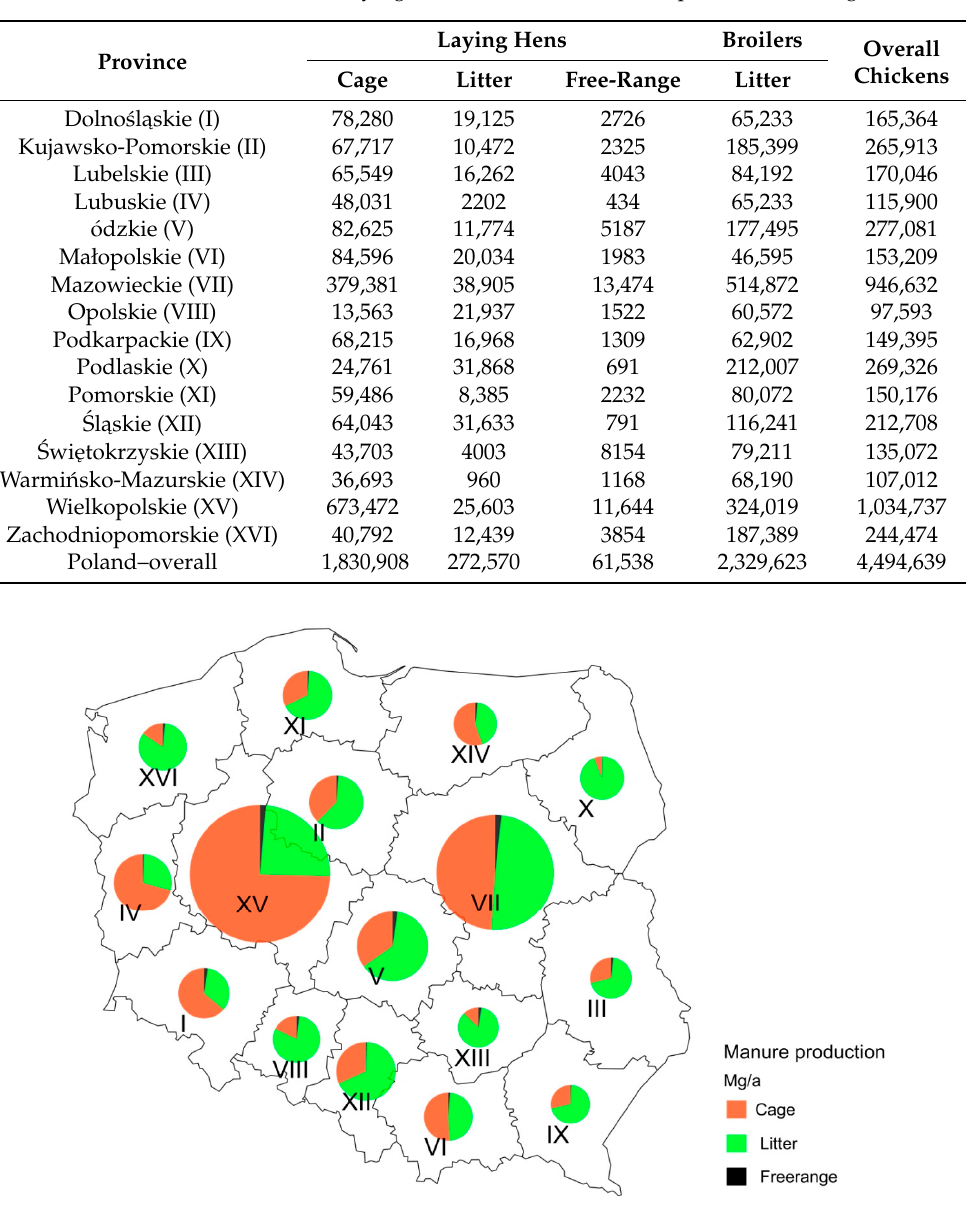
Table 6. Annual chicken (laying hens and broilers) manure production, in Mg.